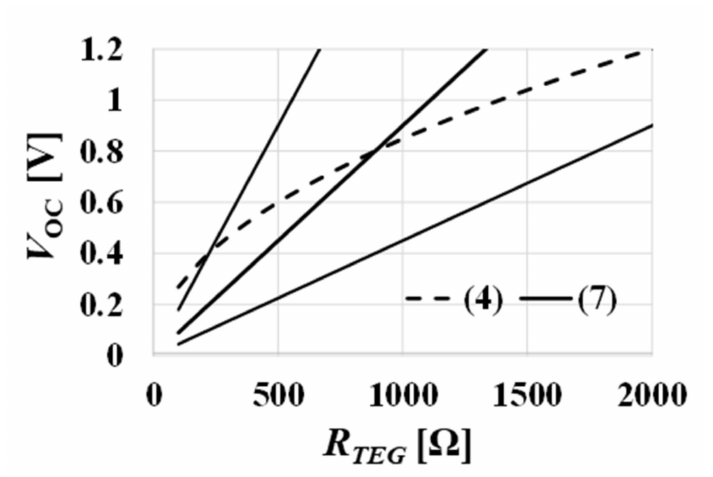
Figure 8. V OC - R TEG curves for TEG/converter power condition (4) and TEG characteristics (7) when V TC / R TC = 0.45 mA, I PP =30 µ A, η = 0.5, V PP = 3